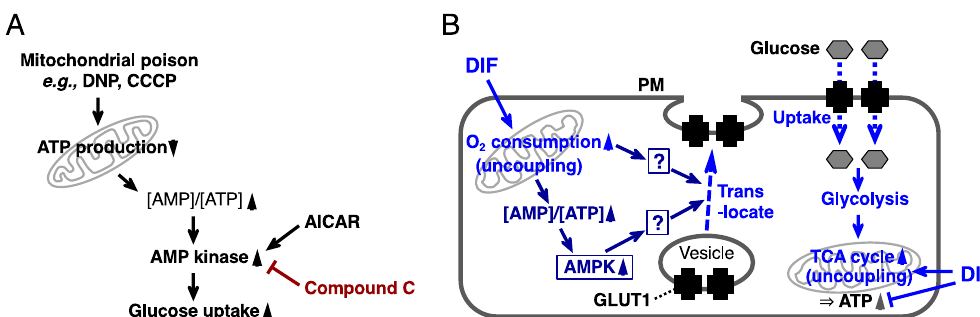
Figure 8. ( A ) Scheme of the actions of mitochondrial poisons such as DNP and CCCP. These compounds reduce ATP production and thus increase the AMP/ATP ratio, activating AMP kinase and promoting glucose uptake. AICAR is an activator and compound C is an inhibitor of AMP kinase. ( B ) Proposed scheme for the actions of DIF. By uncoupling mitochondrial activities, DIF may disturb ATP production and activate AMPK, which may then induce GLUT1 translocation to the plasma membrane and glucose uptake. It is generally unknown how AMPK activation induces GLUT1 translocation, whereas AMPK activation may inhibit GLUT1 internalization (endocytosis) to promote glucose uptake by triggering the degradation of TXNIP (thioredoxin-interacting protein), a stimulator of GLUT1 endocytosis [49,50]. Note that DIF may induce GLUT1 translocation partly via an AMPK-independent pathway, but it remains to be elucidated how DIF induces GLUT1 translocation. Glucose may be metabolized immediately via glycolysis and via the TCA cycle.